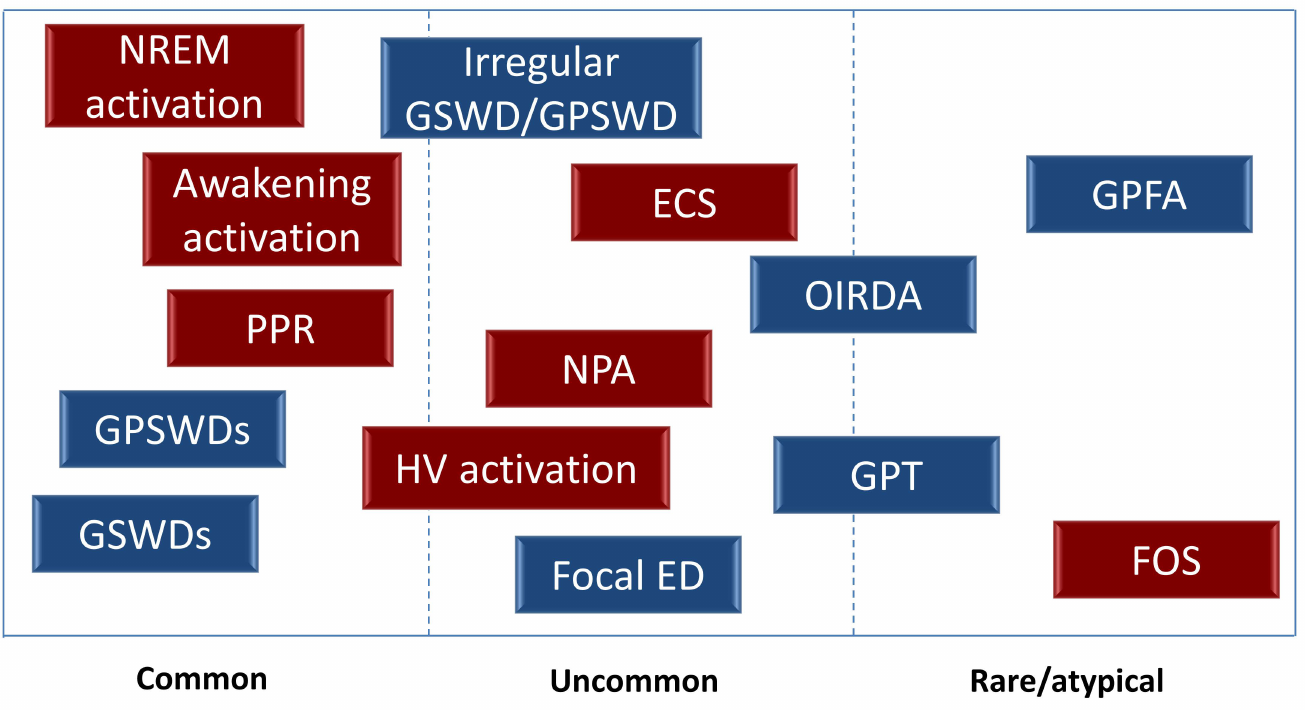
Figure 2. EEG patterns in idiopathic generalized epilepsy. Electroencephalography (EEG) patterns according to the frequency of their occurrence. Spontaneous EEG patterns are indicated in blue, whereas EEG patterns activated by specific conditions/procedure are indicated in red. Abbrevia- tions: ECS = eye closure sensitivity; ED = epileptiform discharges; FOS = fixation-off sensitivity; GPFA = generalized paroxysmal fast activity; GPSWD = generalized polyspike-wave discharge; GPT = generalized polyspike train; GSWD = generalized spike-wave discharge; HV = hyperventila- tion; NPA = neuropsychological activation; OIRDA: Occipital Intermittent Rhythmic Delta Activity; PPR = photoparoxysmal